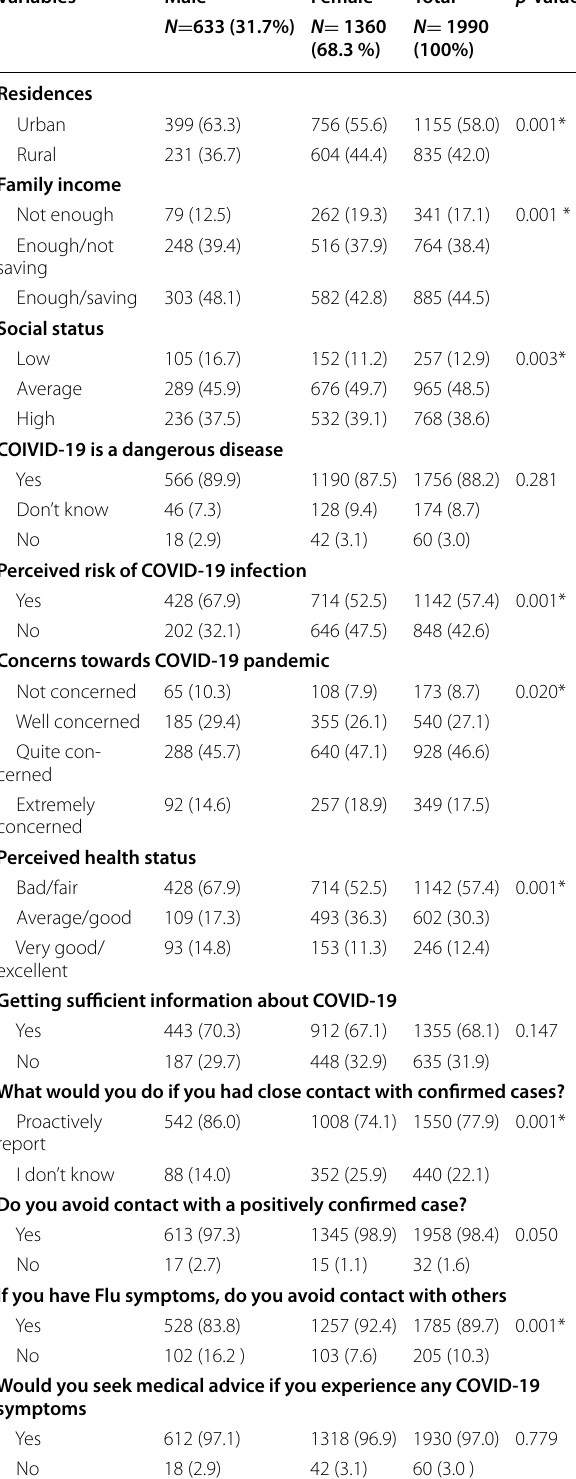
Table 1 COVID-19 pandemic and characteristics of the study participants ( n =